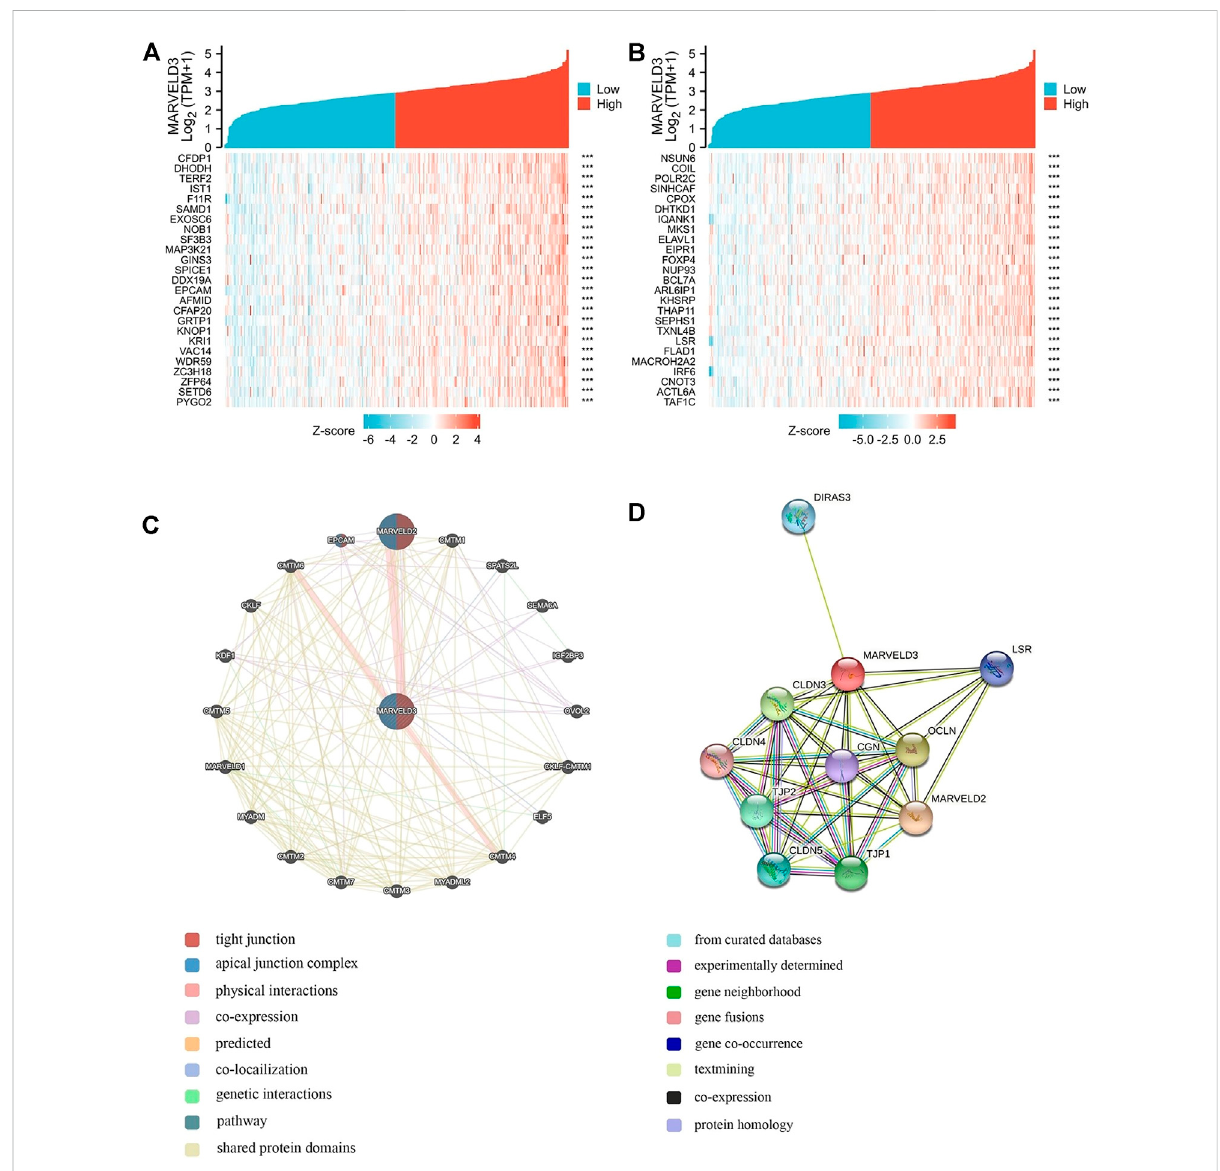
FIGURE 4 MARVELD3correlationinteractivenetworks. (A – B) Top50genesrelatedtoMARVELD3expression. (C) Networkdiagramof20genesassociated with MARVELD3. (D) Protein-protein interaction (PPI) network analysis of 11 interacting proteins correlated with